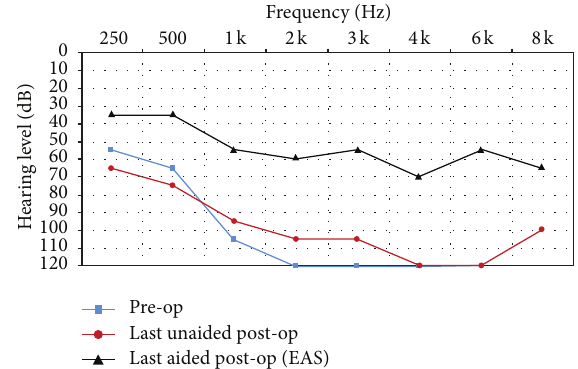
Figure 4: Audiometric results for Subject 4.